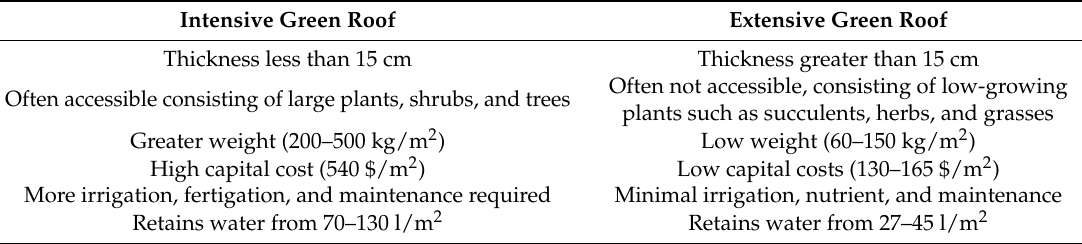
Figure 1. Illustrative green roofs in Dhaka: ( a ) intensive green roof (Basundhara, Dhaka); ( b ) extensive green roof (Gushan, Dhaka). Table 1. Difference between intensive and extensive green Table 1. Difference between intensive and extensive green roofs.